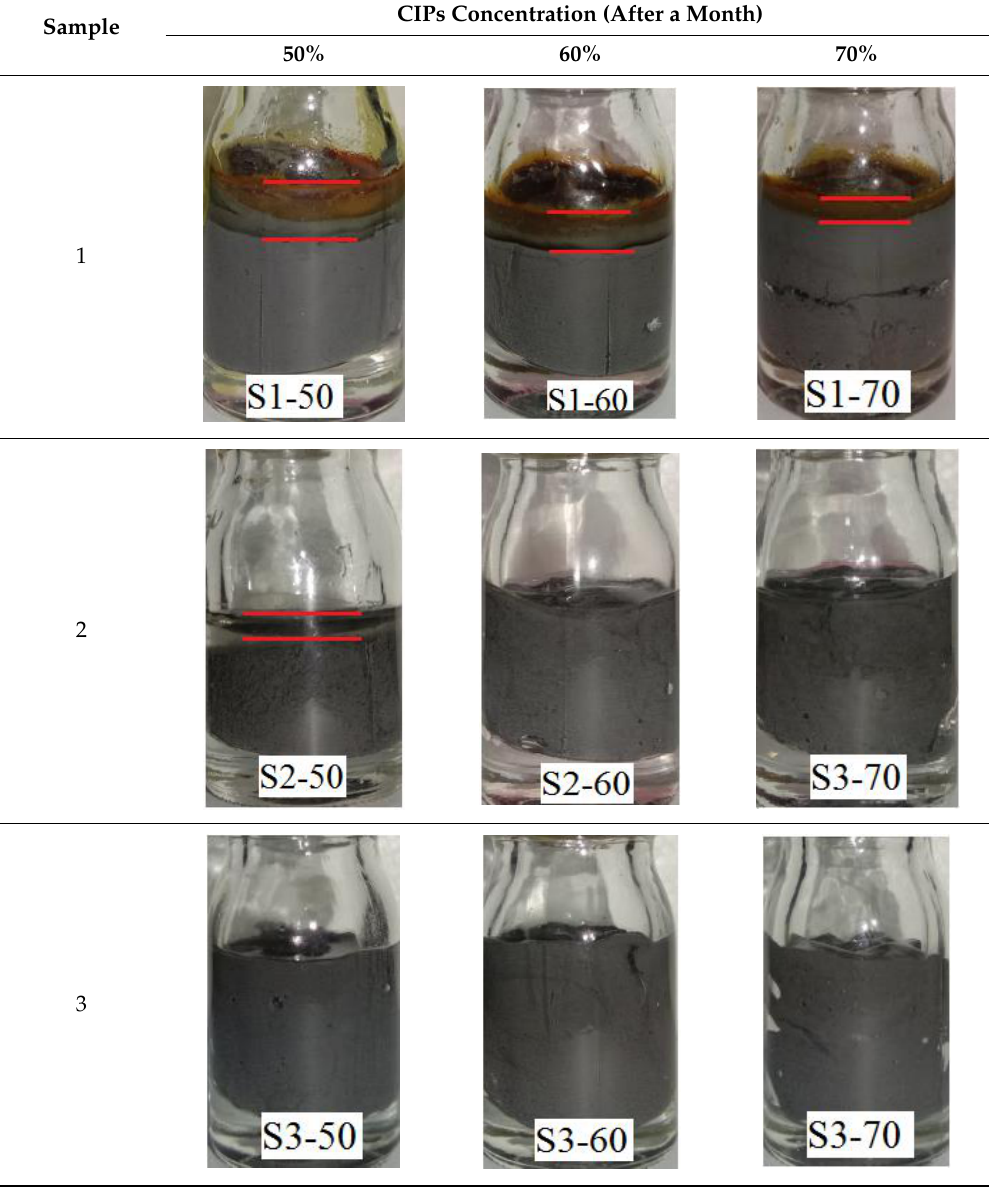
Table 3. Photograph images of MRP samples conditions after a month: Sample 1, Sample 2, and Sample 3 with different concentrations of CIPs.